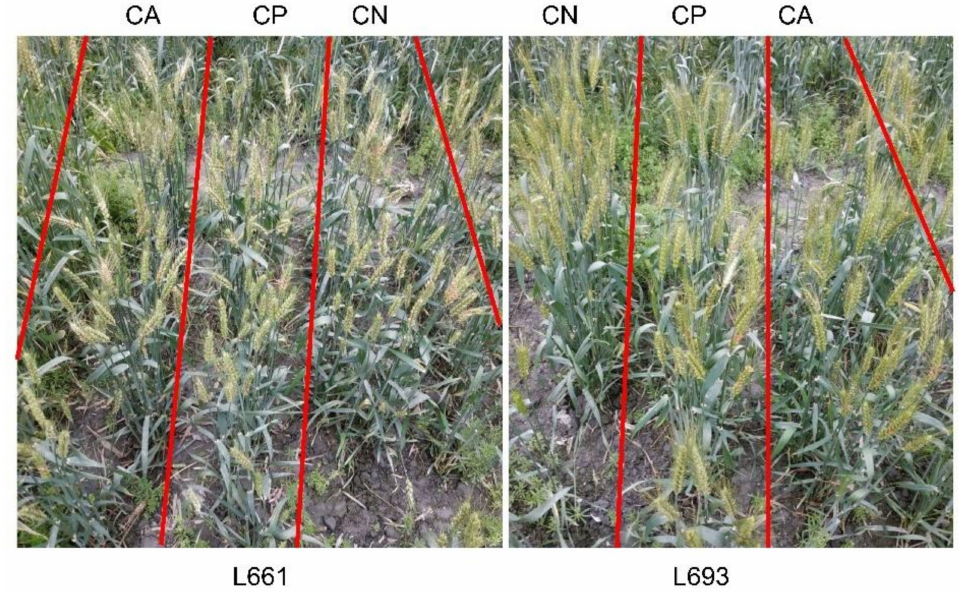
Figure 2. Fusarium head blight symptoms at 21 DAI in field group 1 for L661 and L693. CN, CP, CA − cutting no leaf, cutting some leaves (flag leaf remains), and cutting all leaves,